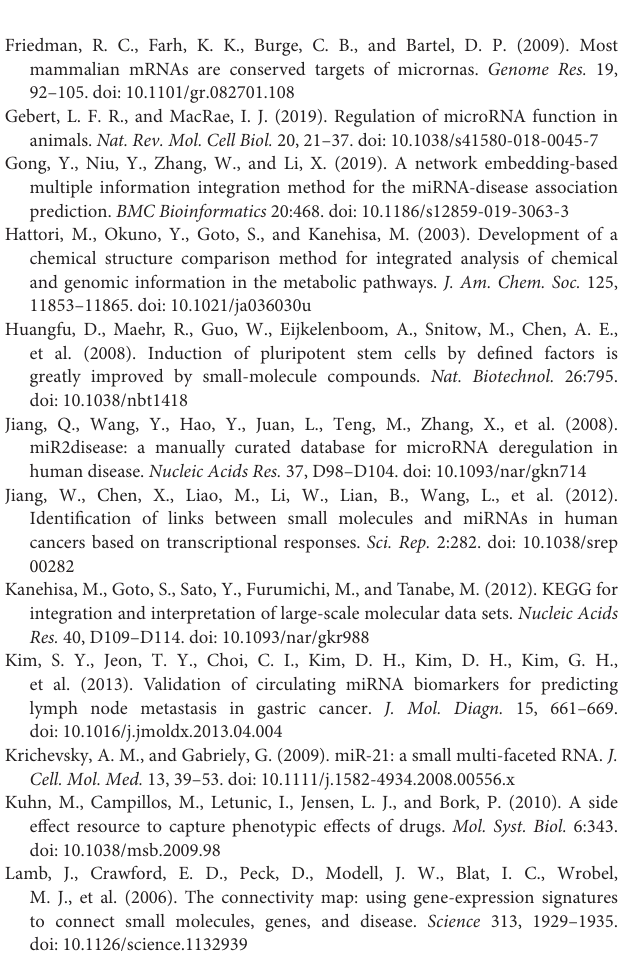
Table S1 | The predicted SMiR association scores based on RWNS in SM2miR1. Table S2 | The predicted SMiR association scores based on RWNS in SM2miR2. Table S3 | The predicted negative SMiR association scores based on CNSMiR in SM2miR1. Table S4 | The predicted negative SMiR association scores based on CNSMiR in